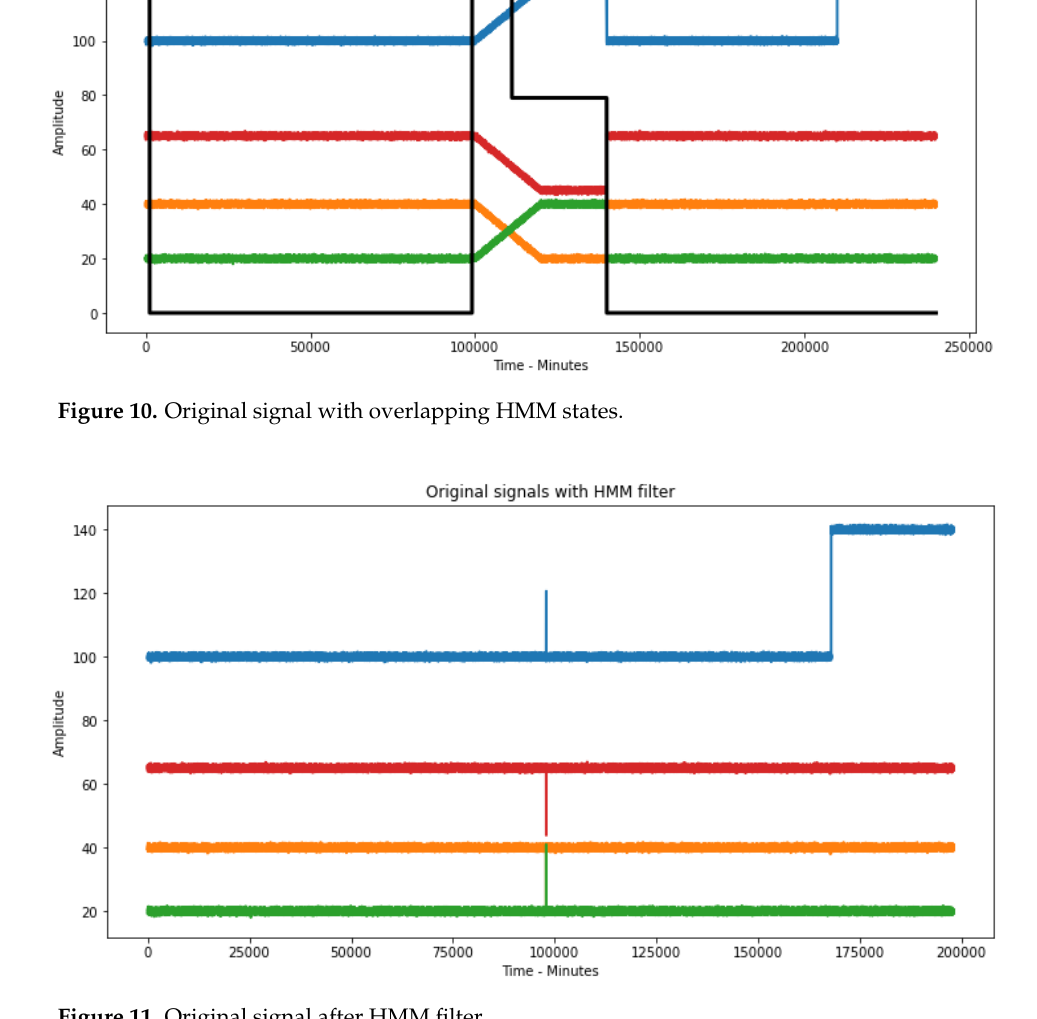
Figure 11. Original signal after HMM